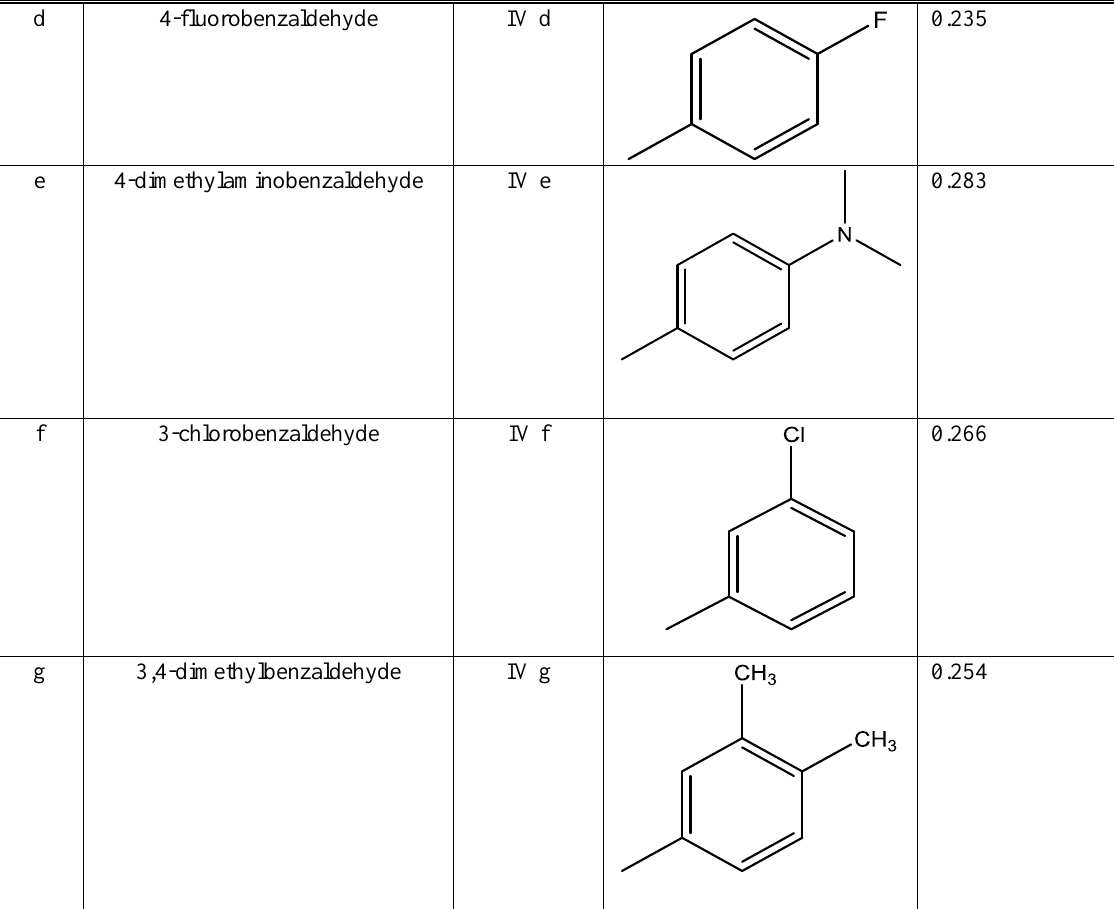
Table (2) 2-(N-(2,3-dimethylphenyl)-2-((2-(4-hydroxyphenyl ) -4-oxothiazolidin-3-yl) amino)acetamido)benzoic acid (IVa) FTIR: 3236 cm -1 (OH phenol & N-H hydrazine); 1782 cm -1 (C=O thiazolidinone); 1732 cm -1 (C=O amide); 1670 cm -1 (C=O of carboxylic acid) and 1238 cm -1 (C-O). 1 HNMR (300 MHz, : DMSOd 6 ) H: thiazolidinone);4.1 (1H,s,CH 2 -NH-N);4.9 (2H,s,CO-CH 2 -NH);6.1(1H,s,N-CH- S)(thiazolidinone); 6.7-7.79 (11H, m, Ar-H); and 10.1 (1H, s, Ar-OH).